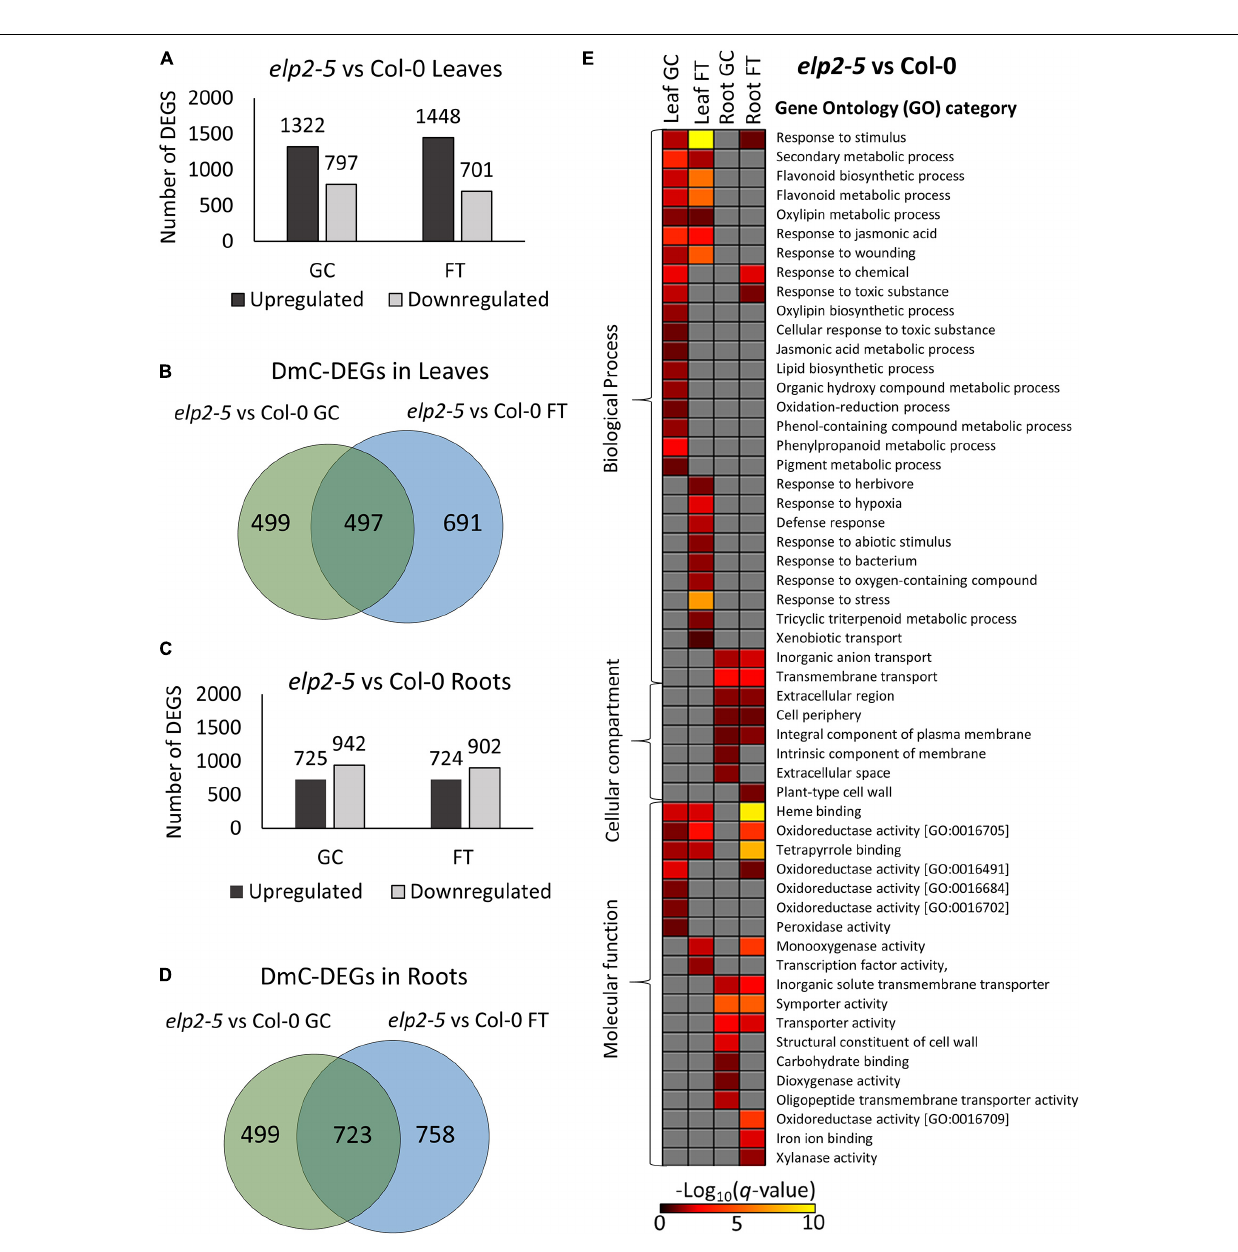
FIGURE 8 | Pairwise comparison of elp2-5 mutant vs wild-type Col-0 DEGs-DmCs on the ground and in spaceflight. (A) Bar graph showing the number of DEGs between elp2-5 and Col-0 leaves on the ground (GC) and in spaceflight (FT). Black bars indicate the number of up-regulated genes whereas gray bars indicate the number of down-regulated genes. (B) Venn diagrams shows the number of DEG-DmCs that overlap between elp2-5 and Col-0 leaves on the ground and in spaceflight. (C) Bar graph showing the number of DEGs between elp2-5 and Col-0 roots in GC and in FT. Black bars indicate the number of up-regulated genes whereas gray bars indicate the number of down-regulated genes. (D) Venn diagrams shows the number of DEG-DmCs that overlap between elp2-5 and Col-0 roots in GC and in FT. (E) Gene ontology (GO) enrichment analyses of DmC-DEG genes in elp2-5 vs Col-0 comparison of both leaves and roots in each environment (GC and FT). The heatmap shows the GO terms that were enriched within each environment and tissue combination between elp2-5 and Col-0. The scale bar represents the negative Log 10 of the q -values (corrected p -values) from the “test of significance of enrichment” within each list of DmC-DEGs. The q -value cutoff was set at 0.05. Higher values in the scaling indicate higher significance of the